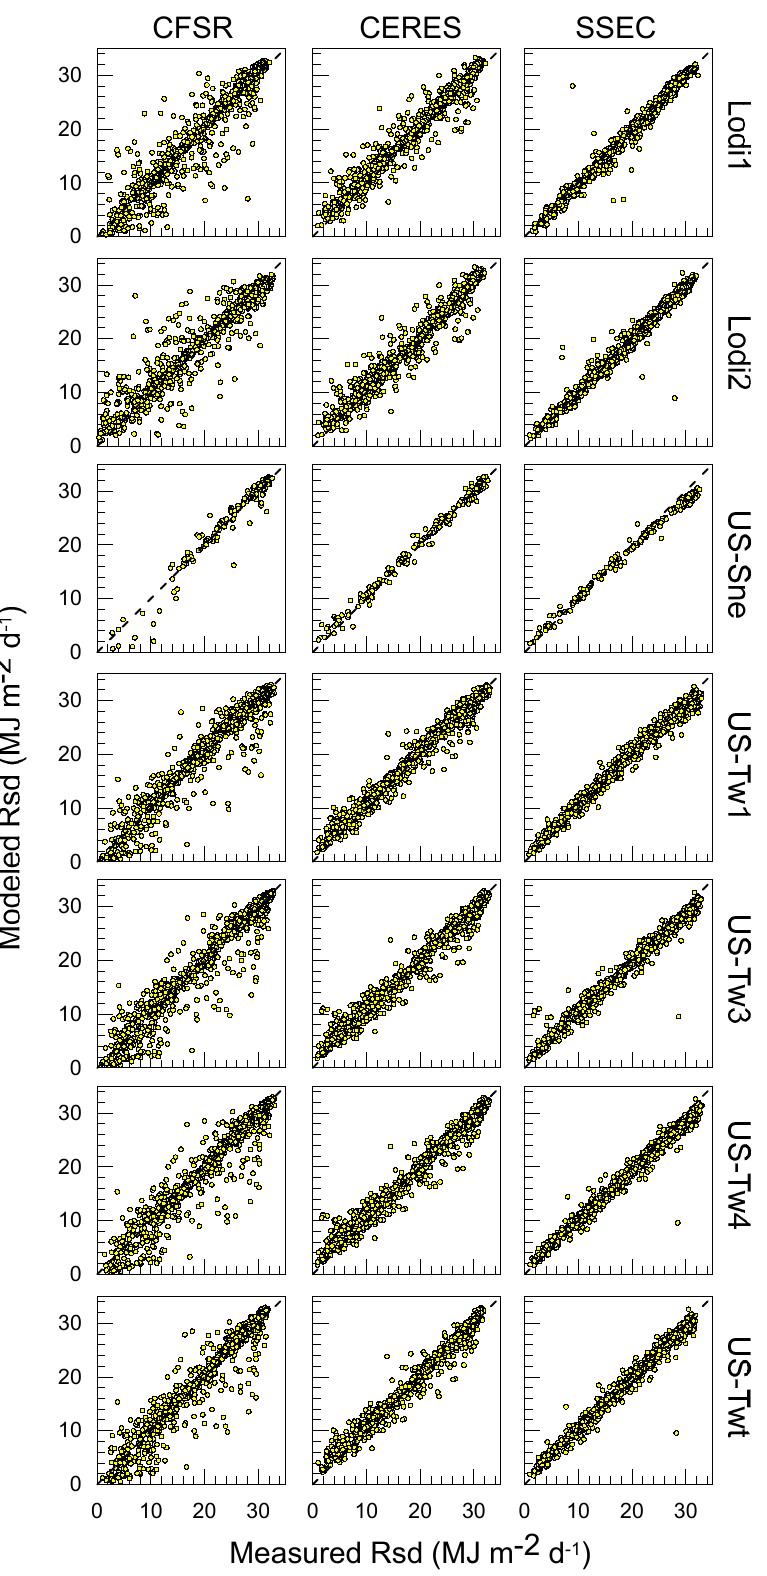
Figure 5. Comparison of the daily insolation fluxes from the CFSR, SSEC, and CERES datasets with pyranometer observations at the flux sites within the study region.